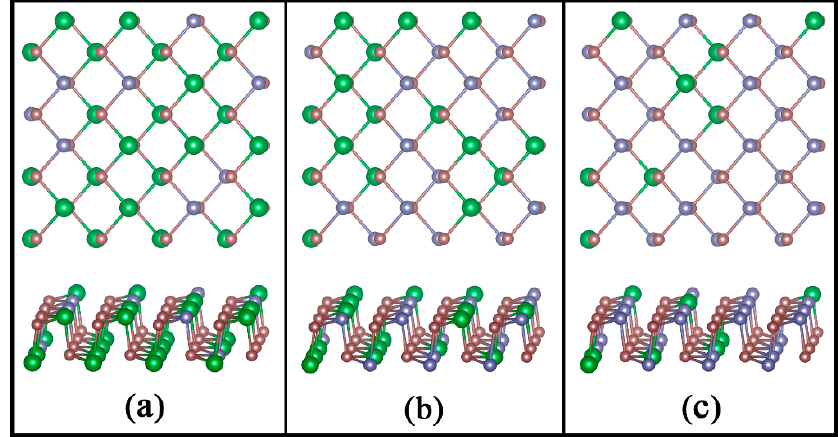
Figure 1. Top and Side Views of ( a ) Ge 8 Sn 24 Se 32 , ( b ) Ge 16 Sn 16 Se 32 and ( c ) Ge 24 Sn 8 Se 32 Monolayers with the Ge Concentration x of 0.25, 0.50 and 0.75, respectively.